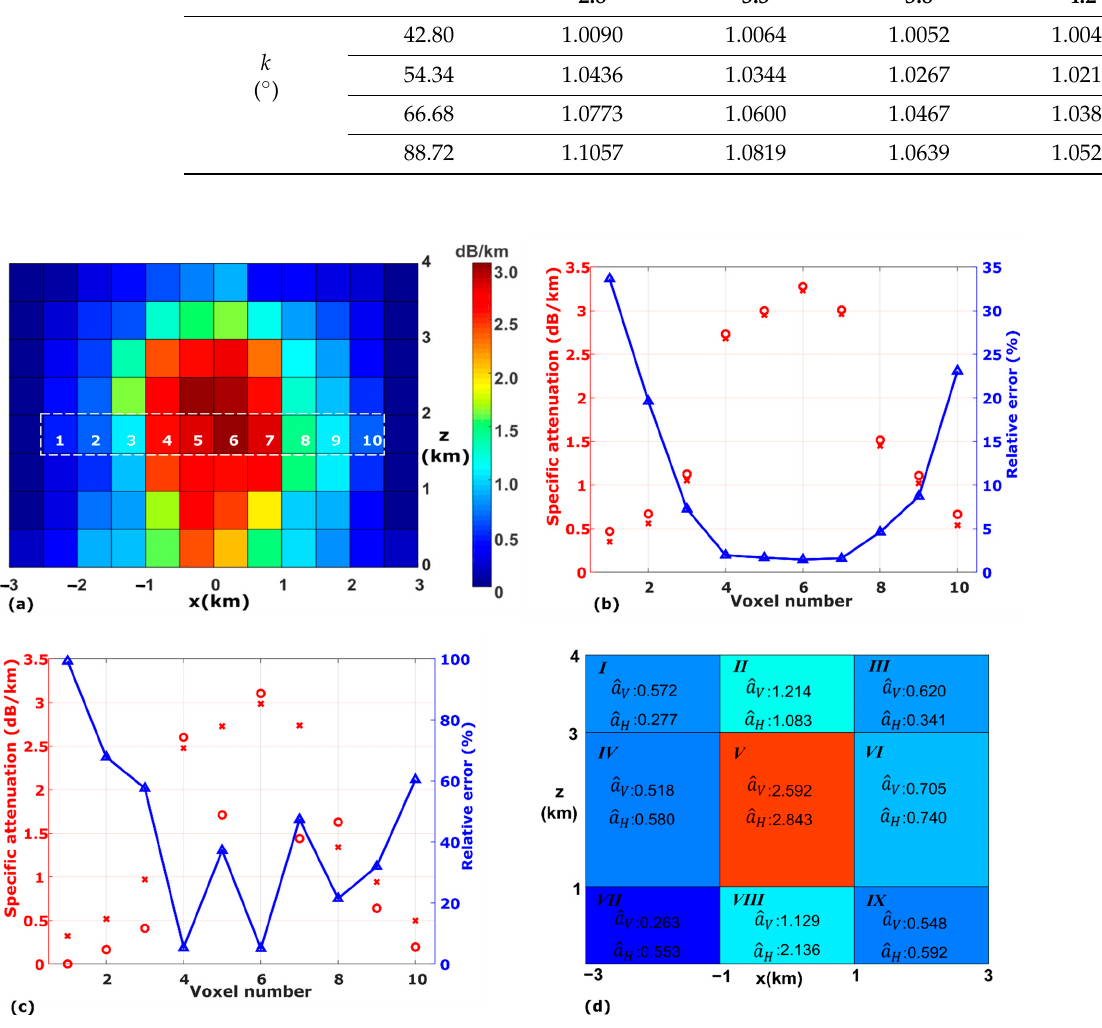
Figure 3. ( a ) The retrieved specific attenuation field for horizontally polarized signals at 40 degrees. ( b ) Retrieval results of horizontal specific attenuations for the ten voxels in the 4th row from the bottom in 100 simulations: the true specific attenuations are marked by red crosses and the average retrieved specific attenuations are marked by red circles. The blue triangles show the relative error. ( c ) Retrieval results of vertical-specific attenuation for the ten voxels in the 4th row from the bottom in 100 simulations: the true specific attenuations are marked by red crosses and the average retrieved specific attenuations are marked by red circles. The blue triangles show the relative error. ( d ) The newly divided nine areas and the retrieved specific attenuations for both horizontal and vertical polarizations.